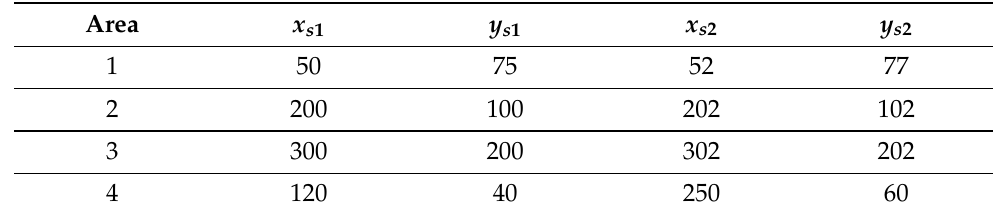
Table 1. Coordinates of measuring areas (in pixels).